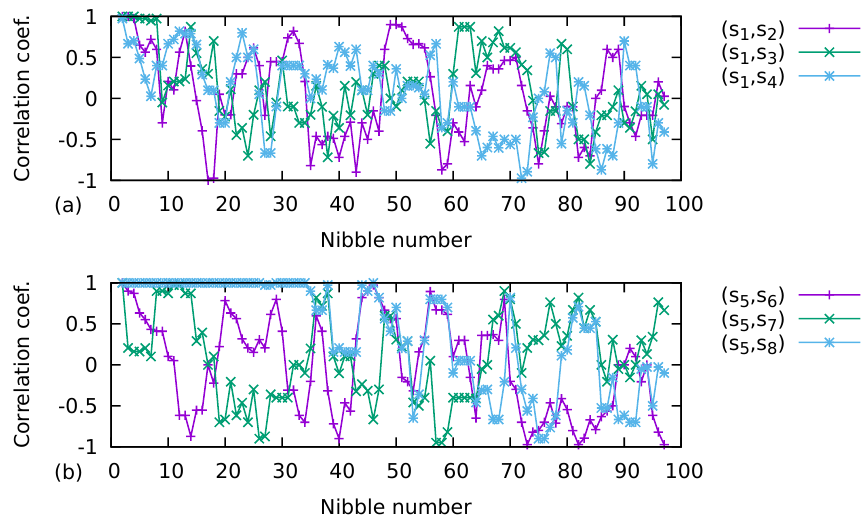
Figure 2. In ( a ) is shown the three correlations between the sequences ( s 1 , s 2 ) , ( s 1 , s 3 ) , and ( s 1 , s 4 ) , and in ( b ), between sequences ( s 5 , s 6 ) , ( s 5 , s 7 ) , and ( s 5 , s 8 )